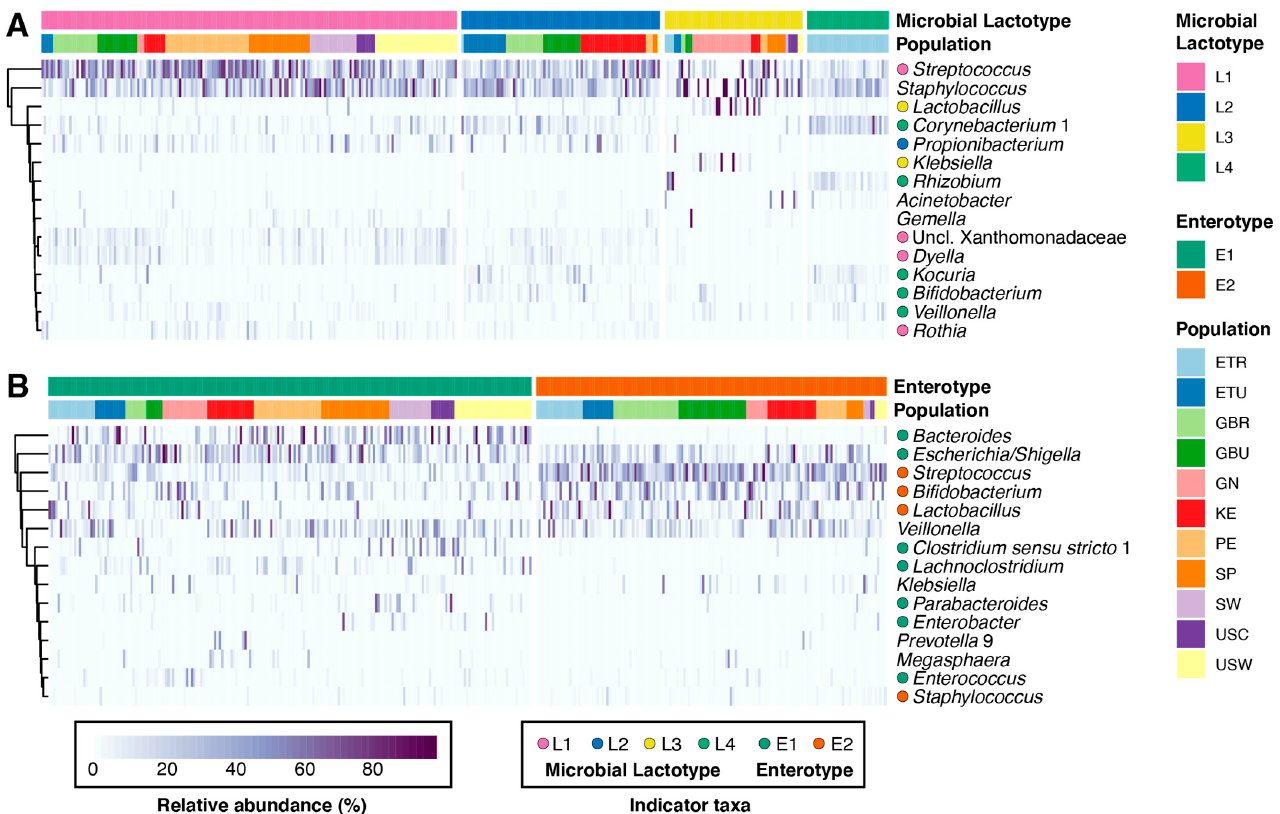
Figure 1. Milk microbial lactotypes and infant fecal enterotypes. Heatmaps of the 15 most abundant taxa (y-axes) within ( A ) milk and ( B ) infant feces (x-axis; n = 357). Colored circles to the left of genera names denote indicator taxa (FDR p < 0.1), defined as taxa estimated to be representative of individual CSTs (microbial lactotypes or enterotypes). See Tables S4 and S5 for the full list of indicator taxa of individual CSTs.